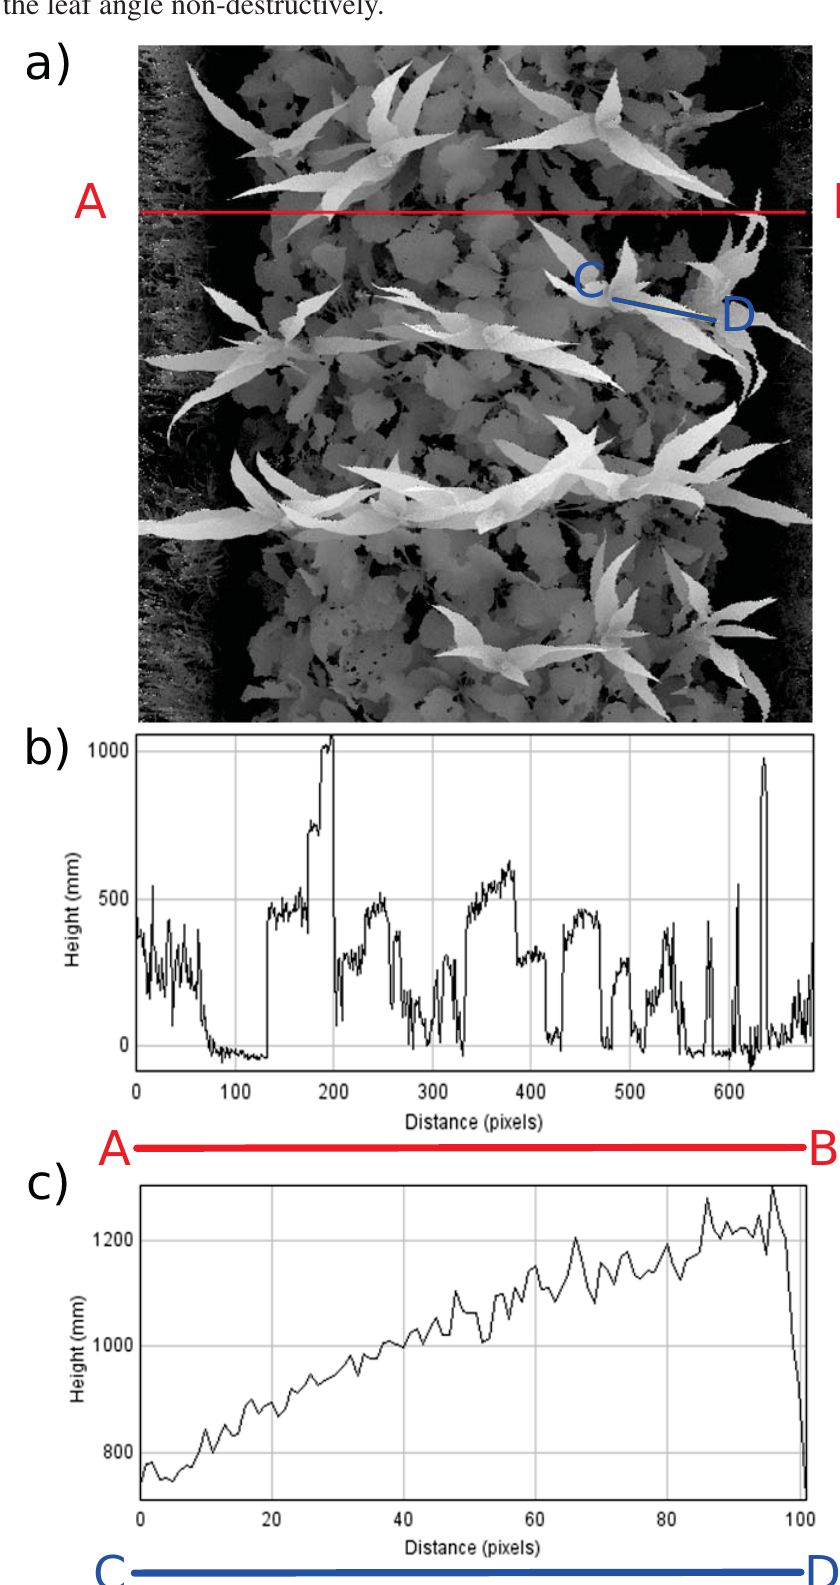
Figure 3. LiDAR data acquired over a mixed plot of forage Brassica and maize. ( a ) Depth image rasterized from the LiDAR height data; ( b ) height profile across the plot (A–B line in red); ( c ) height profile of a single maize leaf (C–D blue line) illustrating the potential to measure the leaf angle